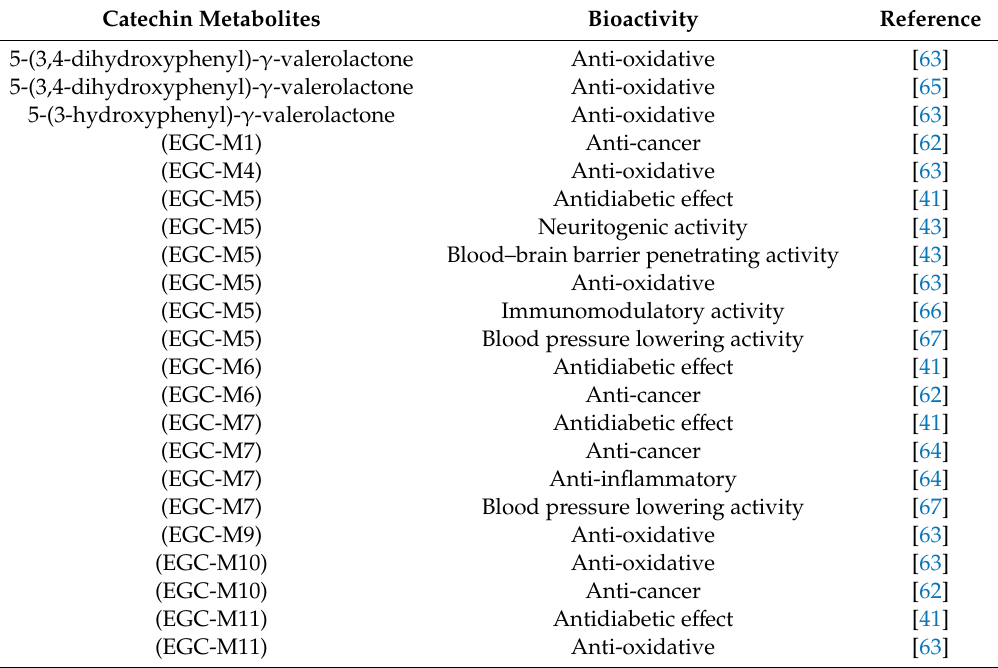
Table 3. Bioactivity of catechin